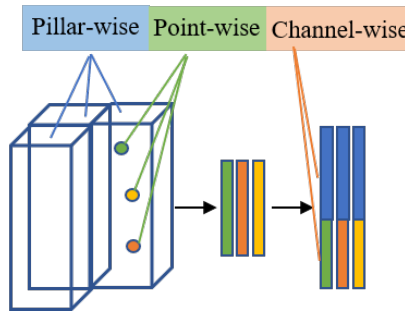
Figure 7. The position in which triple attention is applied.